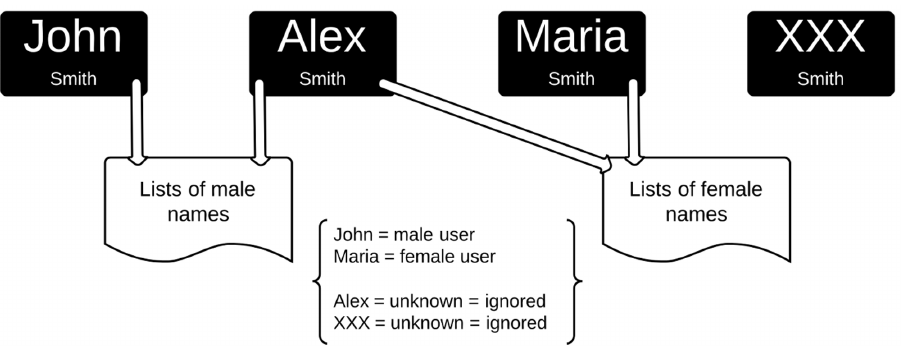
Figure 2. Process of gender inference adopted in this study. According to Burger et al. [15], the method of comparing given names on profiles to lists of predefined gendered names has an accuracy of 89.1% for discriminating gender on Twitter.